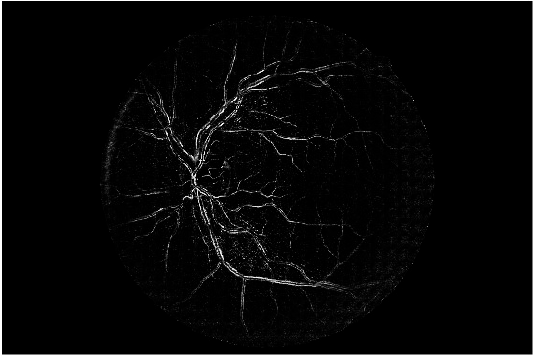
Figure 11. Retinal vessel image of Figure 10.